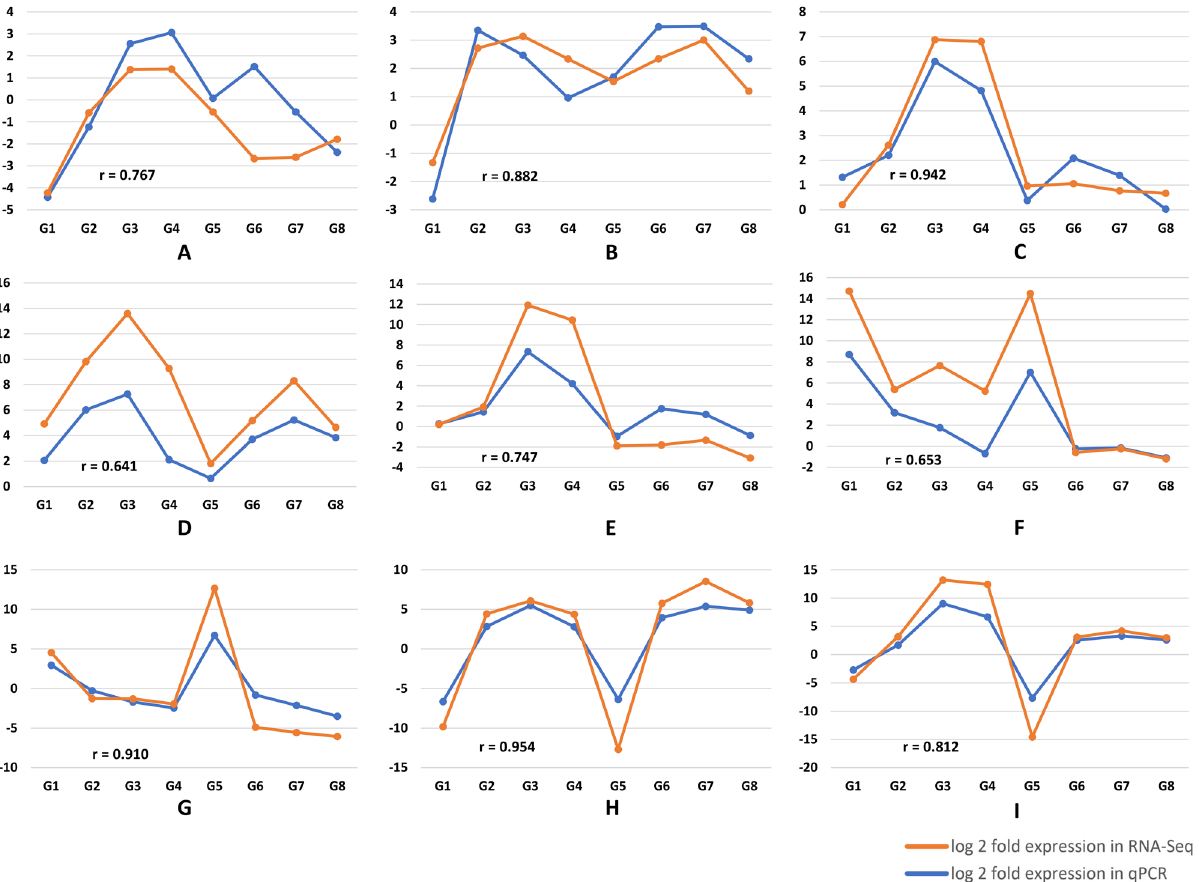
Figure 6. Graphs showing the correlation of log 2 FC of RFOs related genes in qPCR to that of RNA-seq data . A-I represents different sample combinations while G1-G8 represents different genes. A = TG37A (S2 vs